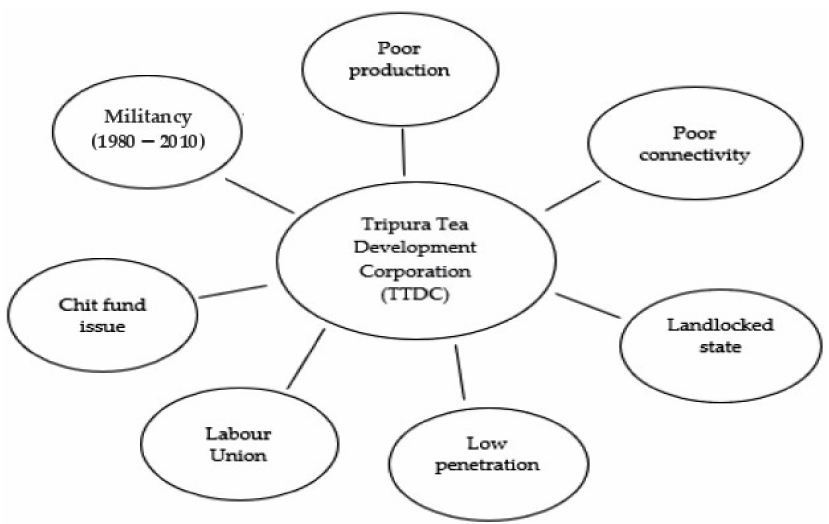
Figure 1. Diagram depicting challenges faced by TTDC (1960–2018).